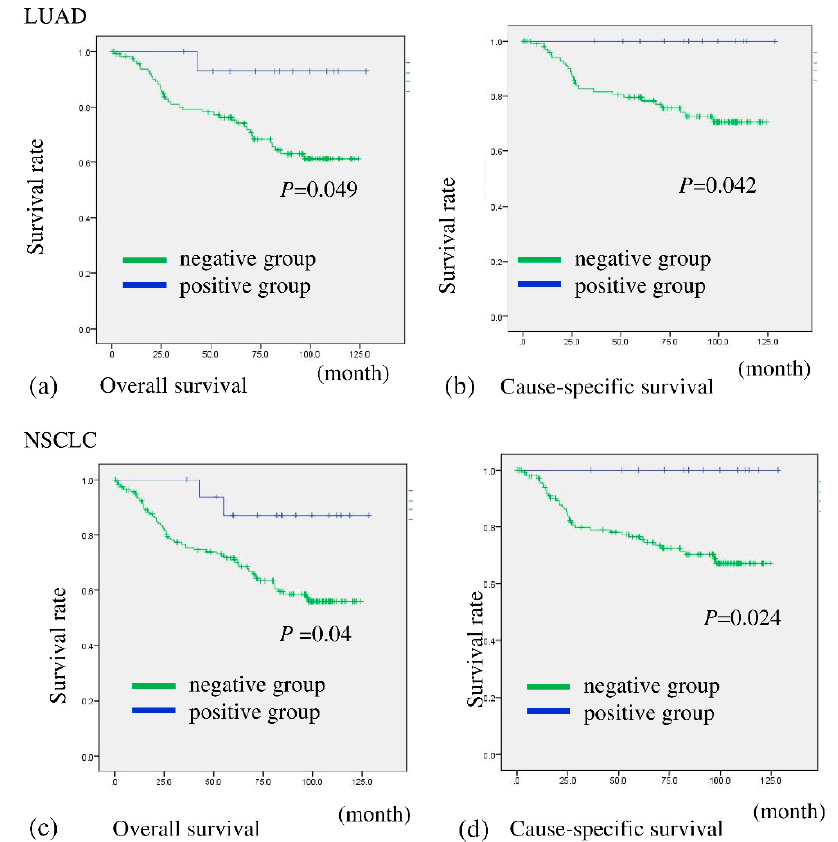
Figure 3. Overall survival and cause-specific survival of patients according to their expression of BHLHE41 in NSCLC and LUAD. Patients with BHLHE41-positive LUAD had significantly more favorable prognoses than those with BHLHE41-negative LUAD for OS ( p = 0.049) ( a ) and CS ( p = 0.042) ( b ). Patients with BHLHE41-positive NSCLC had significantly more favorable prognoses than those of BHLHE41-negative patients for OS ( p = 0.04) ( c ) and CS ( p = 0.024) ( d ). Table 2. Correlation between BHLHE41 expression and clinicopathologic factors in LUAD patients.